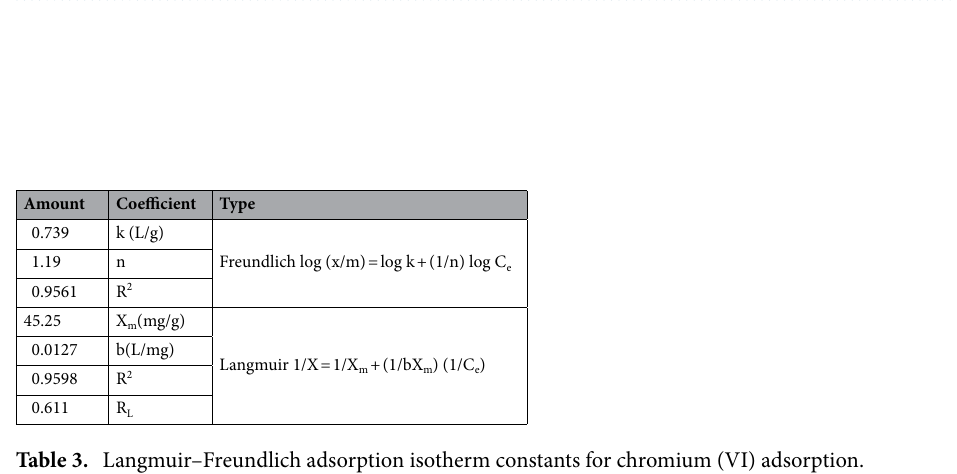
Figure 12. Freundlich isotherms for bee carcasses/polyaniline/polyethylene glycol composite.